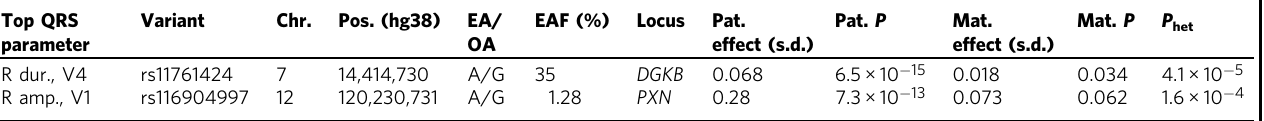
Table 3 QRS variants with parent-of-origin effects Top QRS